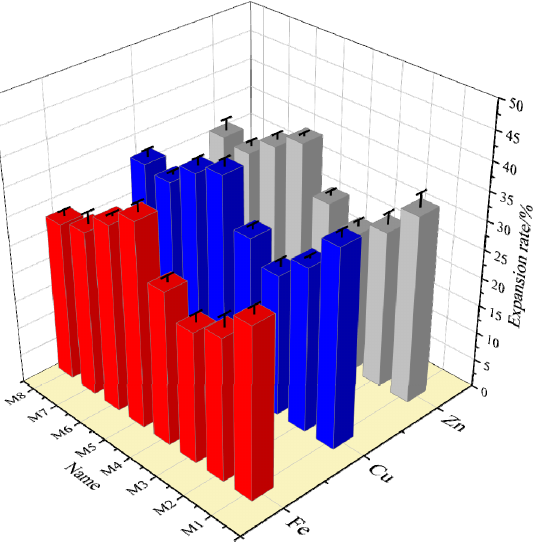
Figure 4. Graph of the linear expansion of different samples at 4% concentration at room temperature and pressure.